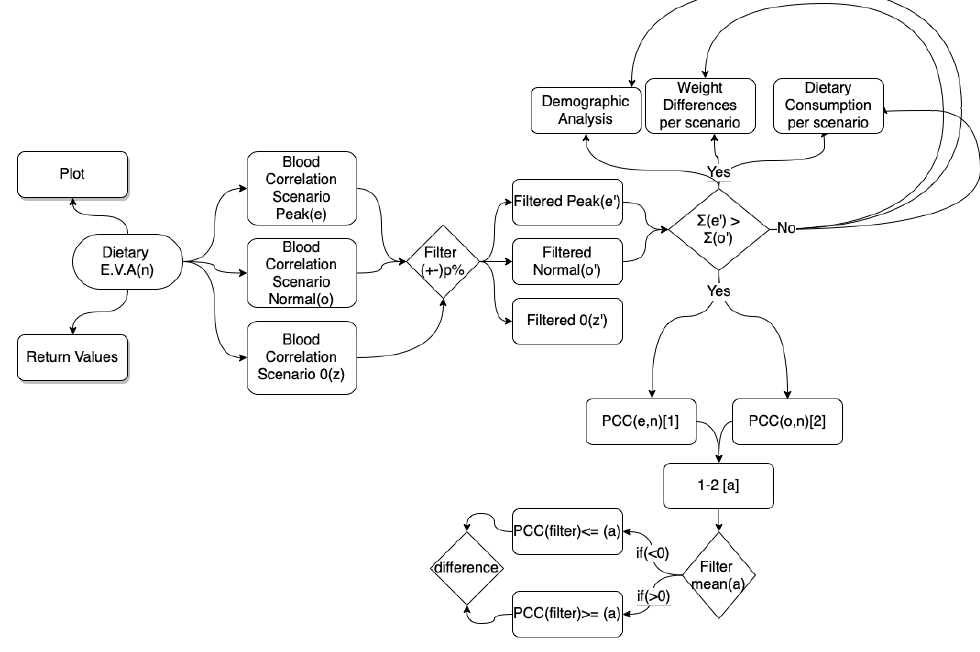
Figure 4. EVA–based decision-making